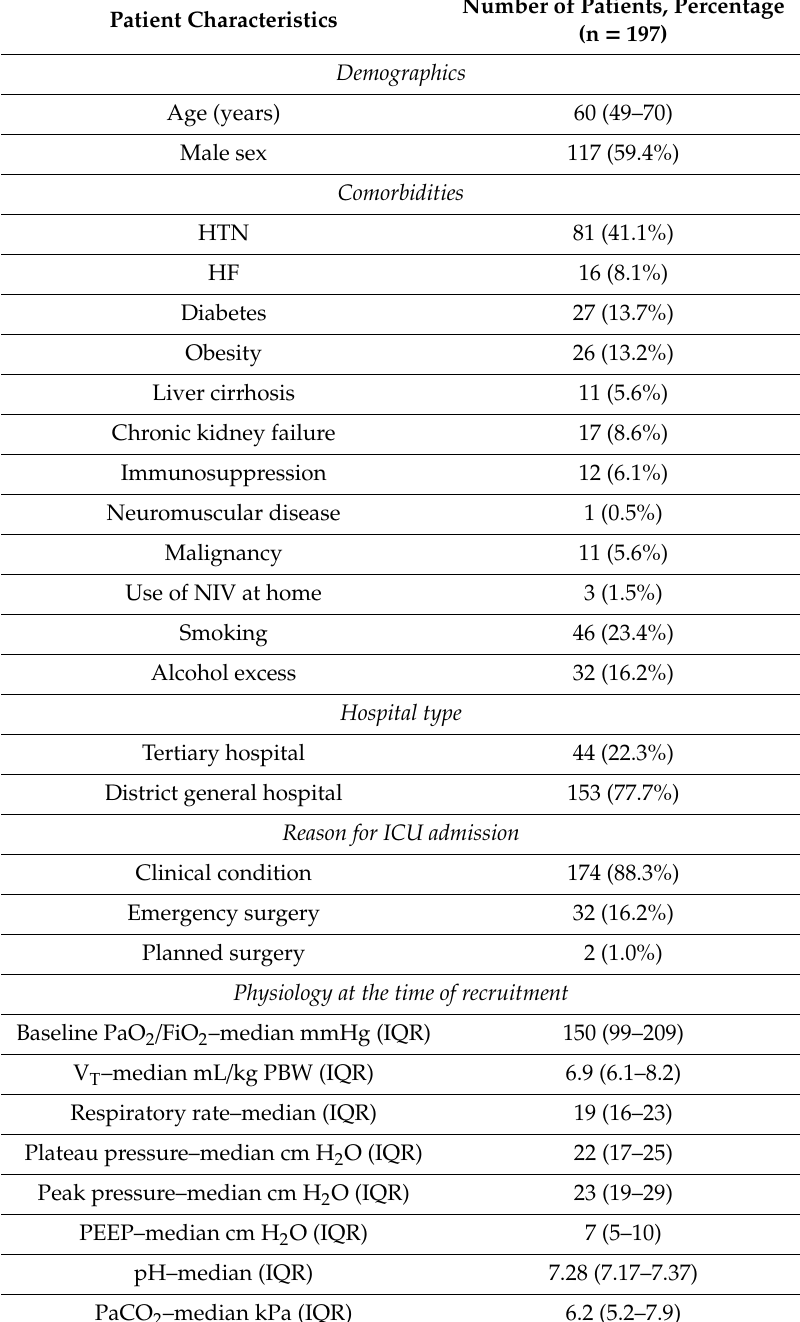
Table 1. Summary of patient demographics and clinical